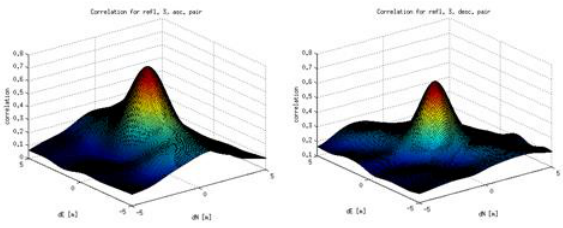
Figure 6. Correlation function for corner reflector